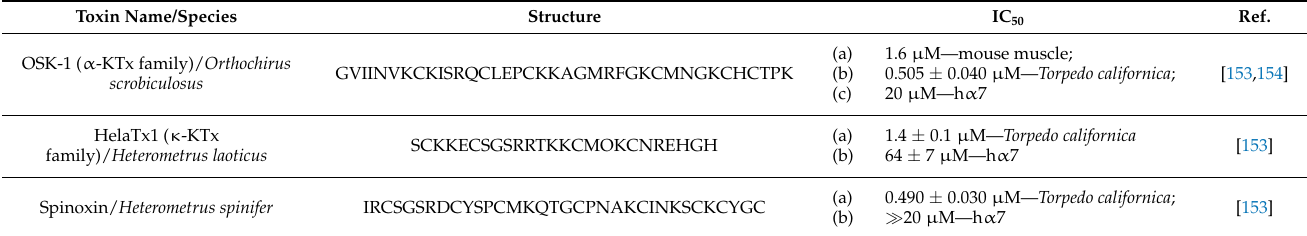
Table 4. The amino-acid sequence and potencies of scorpion toxins targeting nAChRs.